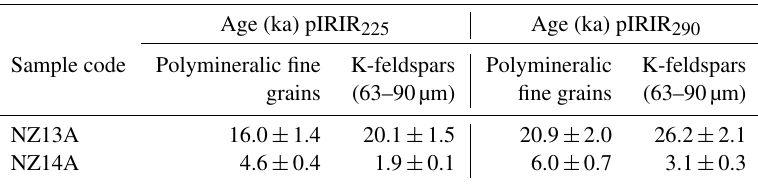
Table 2. Summary of the pIRIR 225 and pIRIR 290 ages obtained on polymineralic fine grains (4–11µm) and coarse K-feldspars (63–90µm). The infrared stimulated luminescence ages were determined considering 15% water content. Uncertainties are given at 1 σ , with a 68% confidence level. Further details are available in the Supplement.